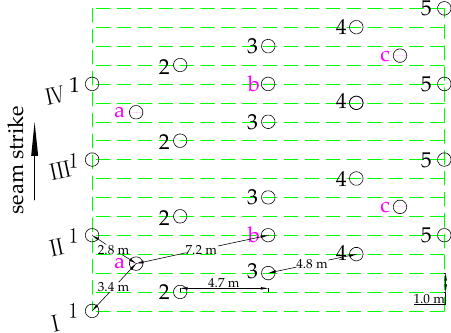
Figure 9. Borehole bottom position of controlled presplitting blasting holes. Table 3. Drilling parameters of controlled presplitting blasting.